Question: Briefly state, in one sentence, what is plotted here.
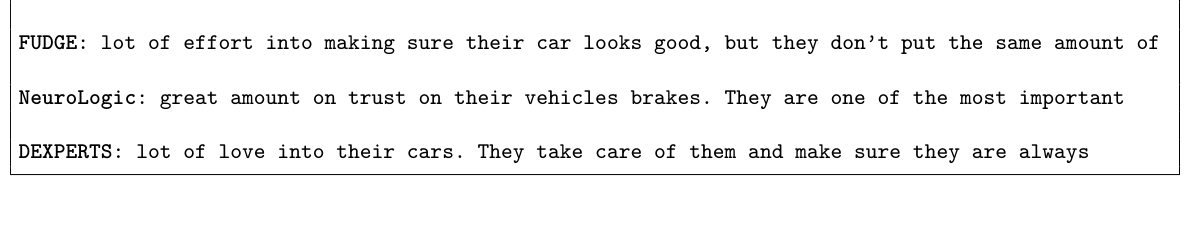
Answer: Randomly selected examples from the Sentiment Control task after partitioning results using the average sentiment score as determined by human annotation.